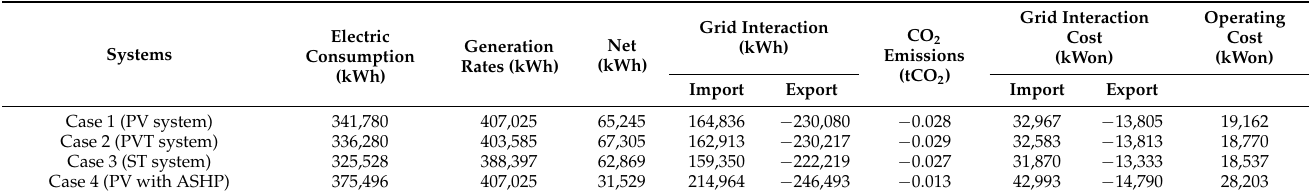
Table 1. Simulation results of the yearly electric energy